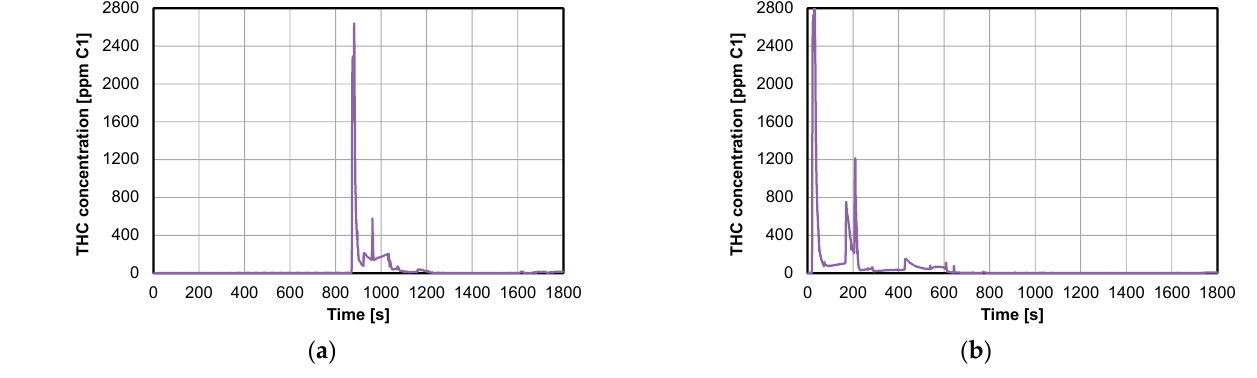
engine. In addition, in the case of HEV, the THC concentration slowly decreased with the increase in absolute velocity values as observed from 60 km/h, which reflected the in- creased use of a combustion engine during driving. Figure 14. The NO x concentration versus actual velocity for: ( a ) plug-in; ( b ) HEV.